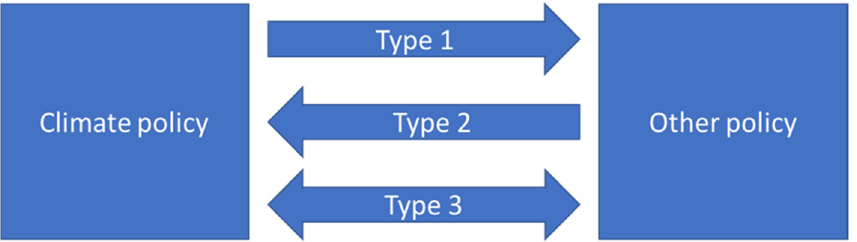
Figure 2. A framework and taxonomy for climate-related